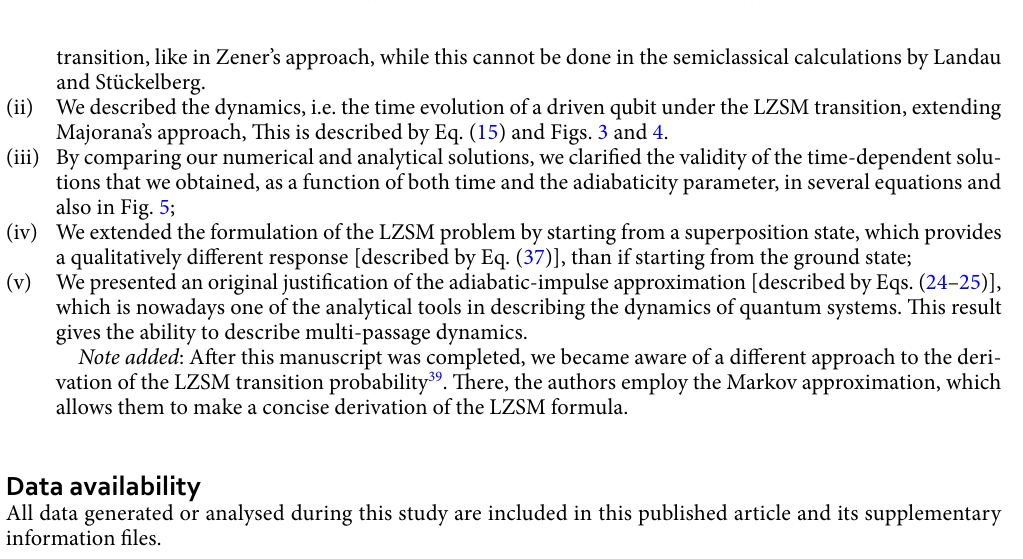
Figure 5. Validity of Majorana’s approach. This is quantified as the difference of the upper-level occupation probability calculated by both the asymptotic Majorana’s method and the exact Zener’s result. The initial 0 (a) and the superposition state (b) with α i 0.7 . Here P Z condition is taken to be the ground state with α i = = 2 from Eq. (28). Then P α(τ) is Zener’s probability, which is given by M is our result within Majorana’s approach, | | 2 from Eq. (37). The dashed blue curves show the jump time τ α(τ) which is provided by jump , Eq. (31). Panel (c) | | shows a magnified view of the (b) dependence at non-adiabatic range of the adiabaticity